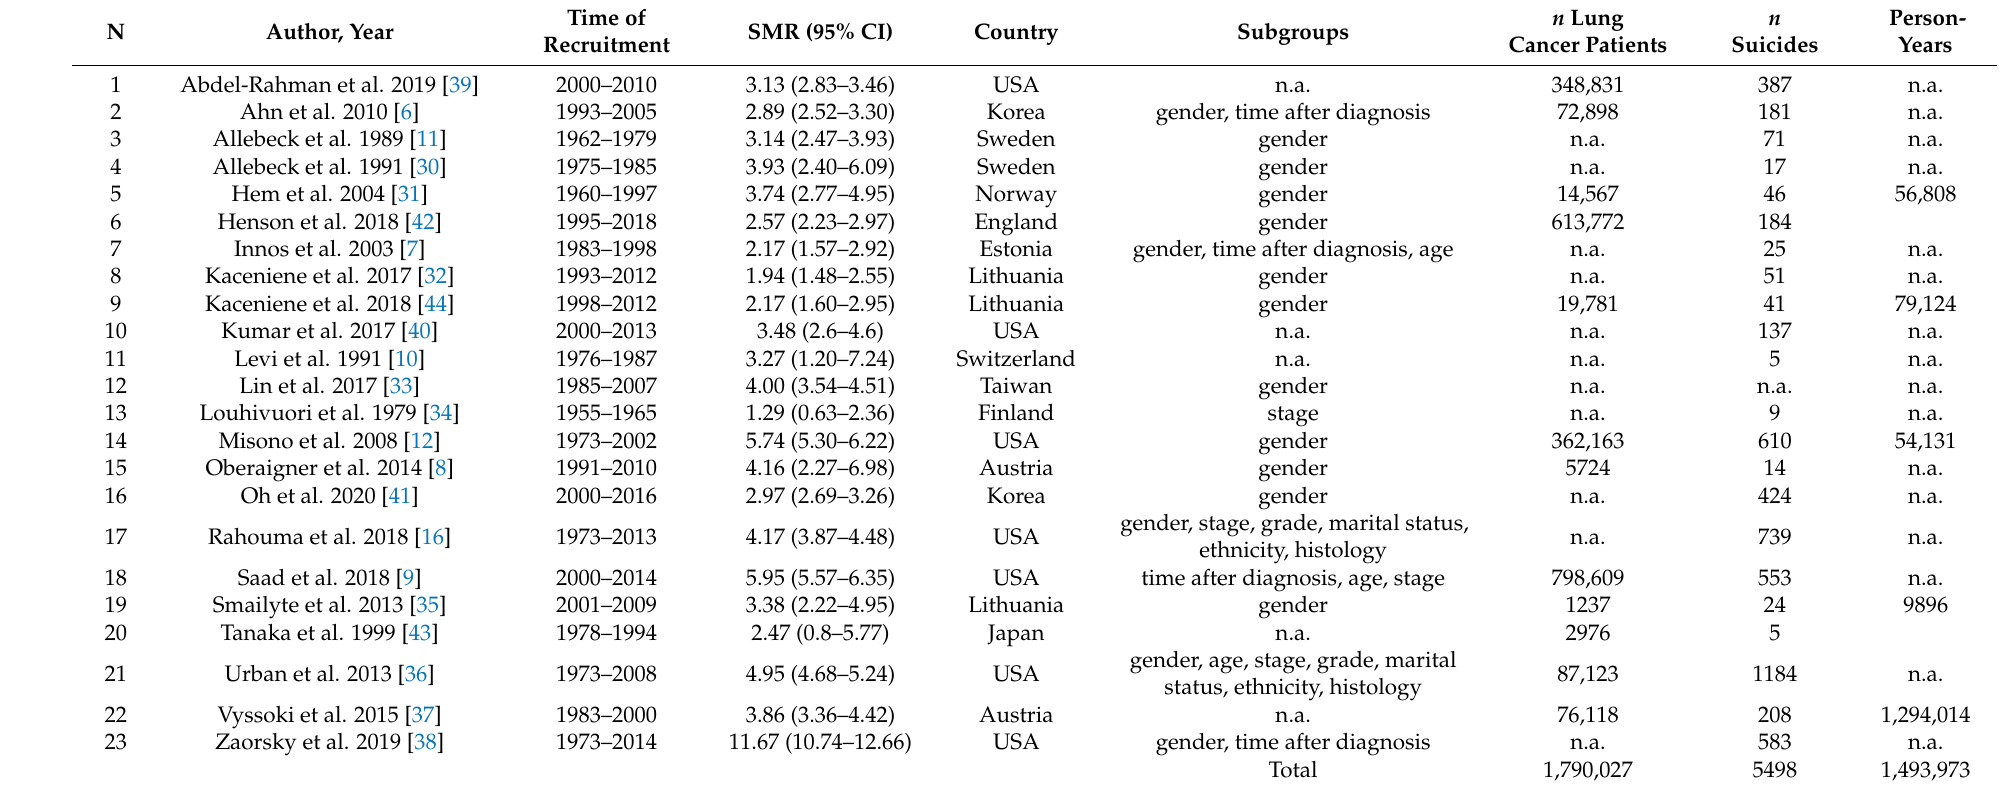
Table 1. Characteristics of included